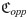
Our tuned model predicts color shifts from [18].Left. Observer ‘MC’. Right. Observer ‘AZ’. Red dots indicate experimental data, while blue crosses stand for predicted matching comparison colors. The data has been averaged over three sets of experiments, as detailed in the original article. The ordinate corresponds to the color shift, expressed in Copp coordinates with c = s − 1 . The abscissa i = 0, …, 7 refers to the test pattern: p/p, l/l, p/w, l/w, w/p, w/l, p/l, l/p, where p stands for purple, l for lime, w for white.